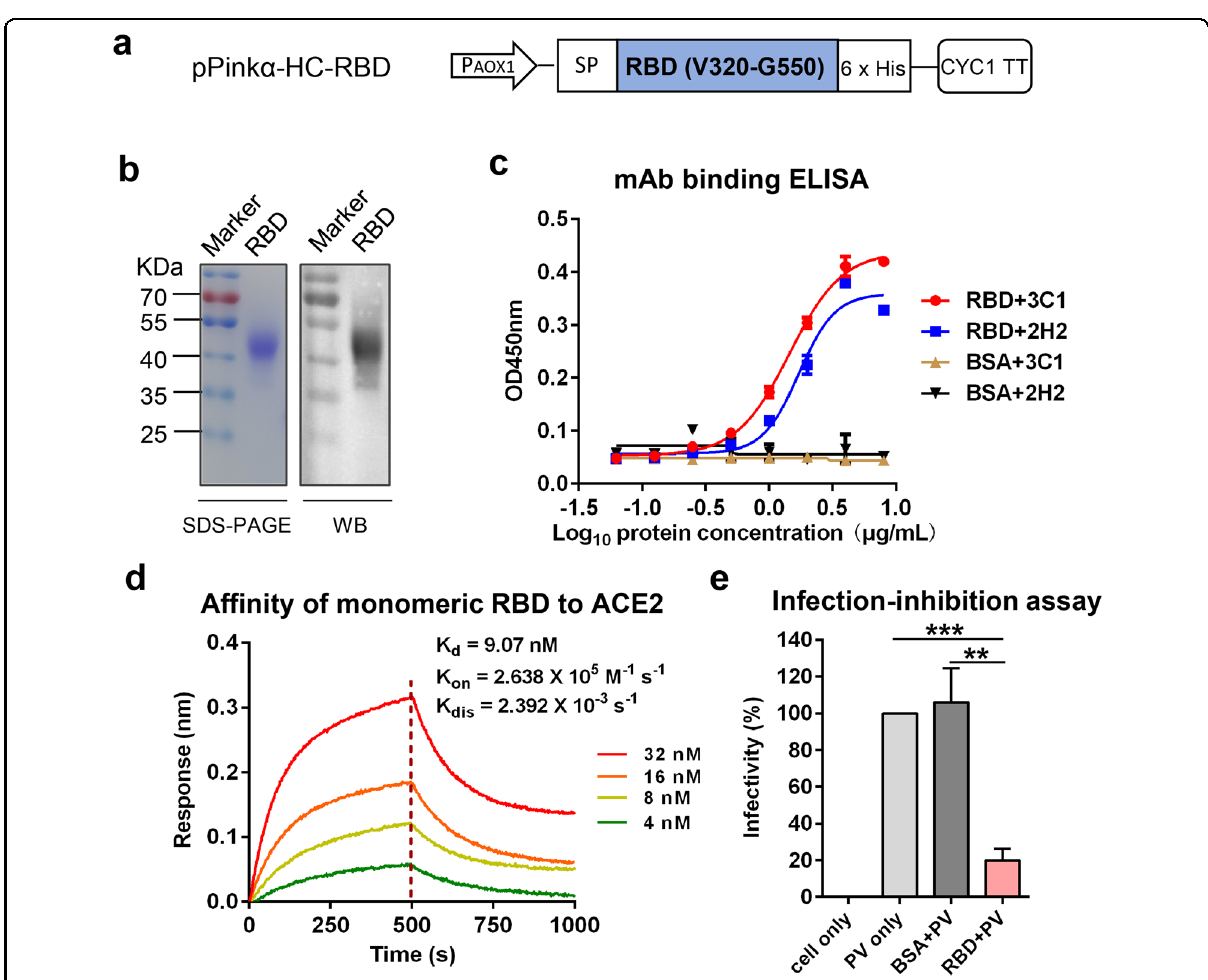
Fig. 1 Production and characterization of recombinant monomeric RBD protein of SARS-CoV-2 in yeast. a Schematic diagram of the expression construct pPink α -HC-RBD. P AOX1 , AOX1 promoter; SP, signal peptide; CYC1 TT, CYC1 transcription termination region. b SDS-PAGE (left panel) and western blotting (WB; right panel) analysis of puri fi ed SARS-CoV-2 RBD protein. An anti-RBD (inclusion bodies) polyclonal antibody served as the detection antibody in WB assay. c Reactivity of yeast-derived RBD with neutralizing MAbs 2H2 and 3C1 determined by ELISA. BSA served as negative control. Data shown are means ± SEM of OD450 readings from triplicate wells. d Binding af fi nity of yeast-derived RBD to immobilized hACE2-Fc determined by BLI. RBD protein concentrations used were shown. e Inhibition of cell entry of SARS-CoV-2 pseudovirus (PV) by yeast- produced RBD protein. Data are means ± SEM of triplicate wells. Statistical signi fi cance was determined by Student ’ s t -test and indicated as follows: ** P < 0.01; *** P <